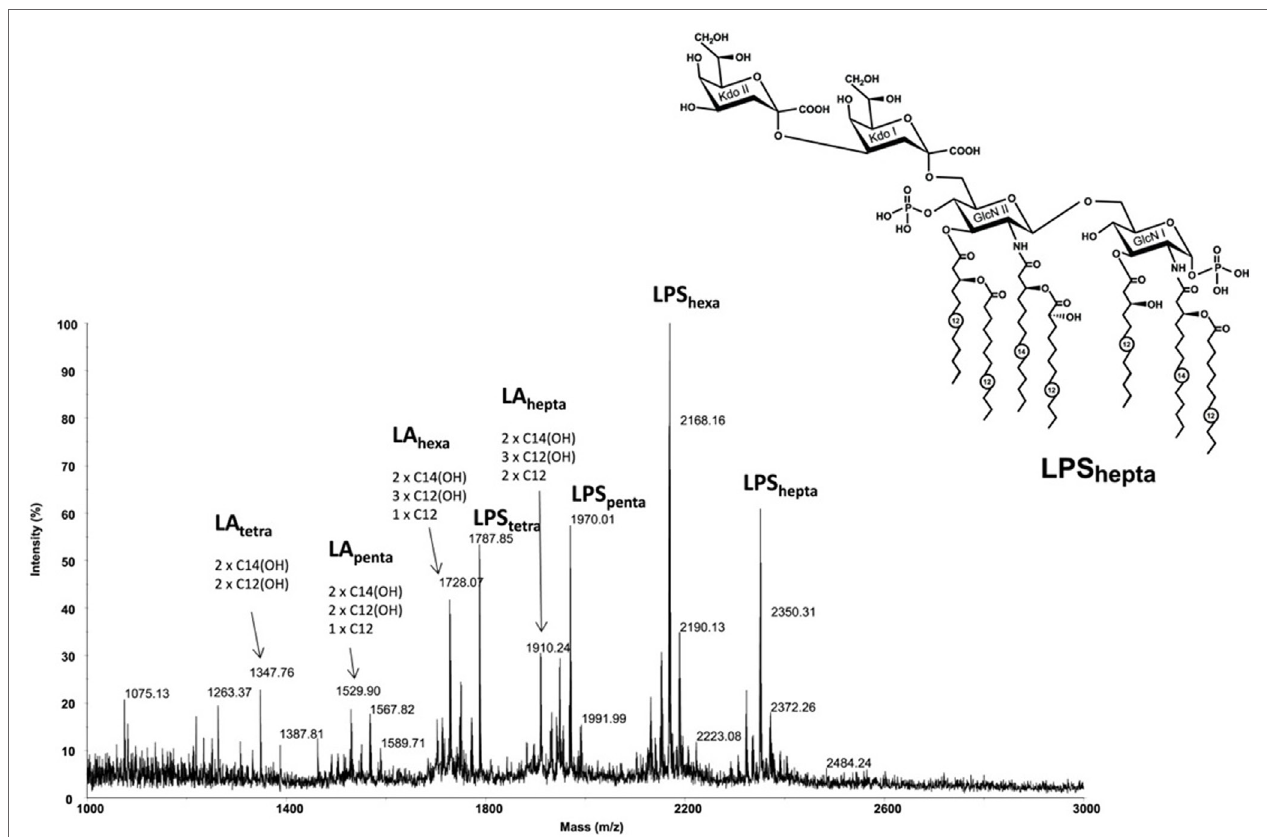
FigUre 1 | high resolution MalDi-TOF mass spectrum of Acinetobacter baumannii 1053 lPs recorded in the negative ionization reflectron mode . Structure of the heptaacyl lipid A in LPS from A. baumannii. Kdo, 3-deoxy- d - manno -oct-2-ulosonic acid; GlcN, glucosamine. Numbers indicate the number of carbon atoms in the acyl